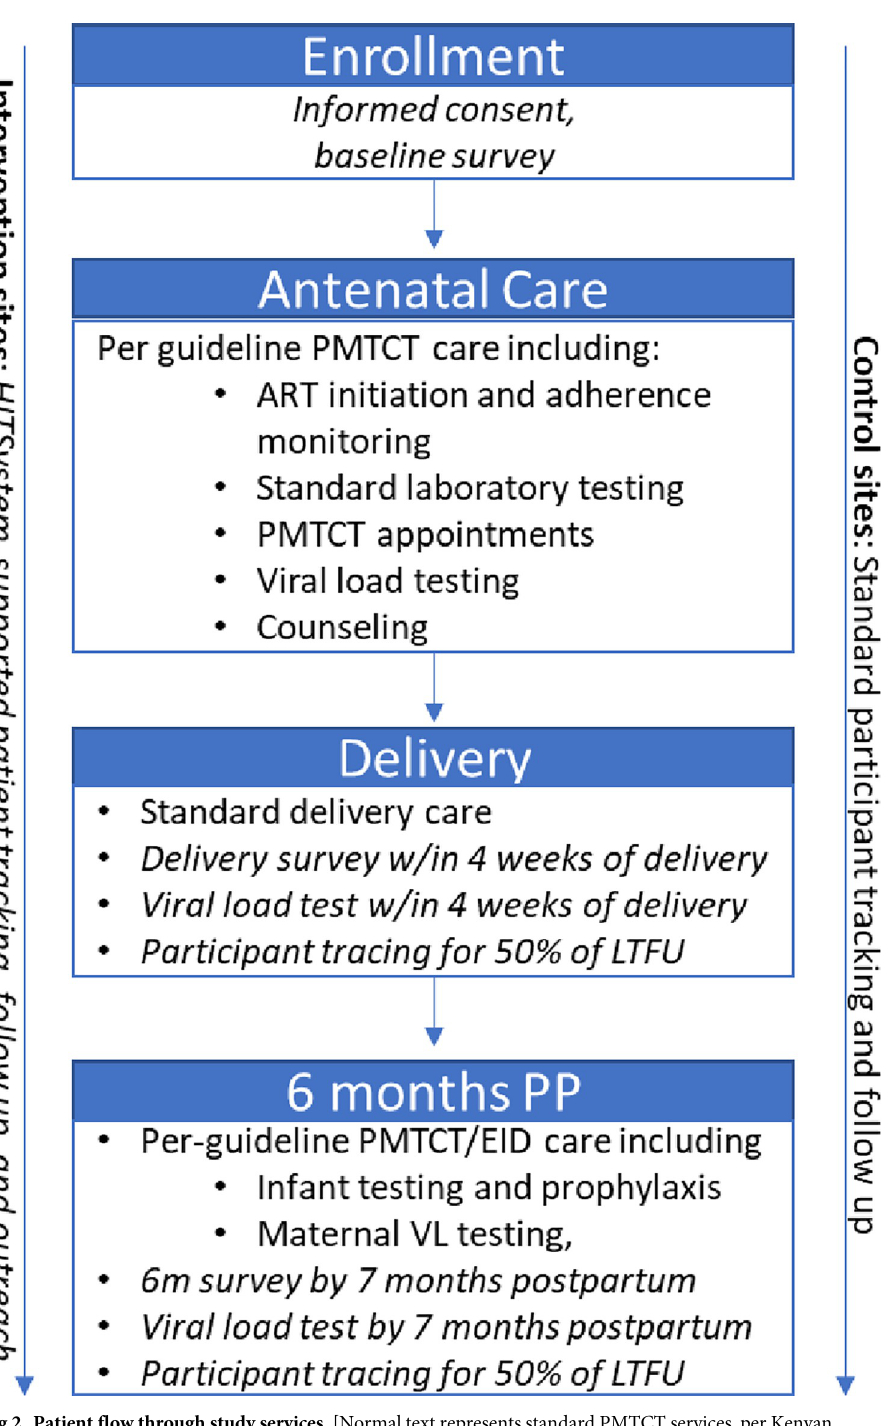
Fig 2. Patient flow through study services. [Normal text represents standard PMTCT services, per Kenyan guidelines. Italicized text represents study-specific services.].